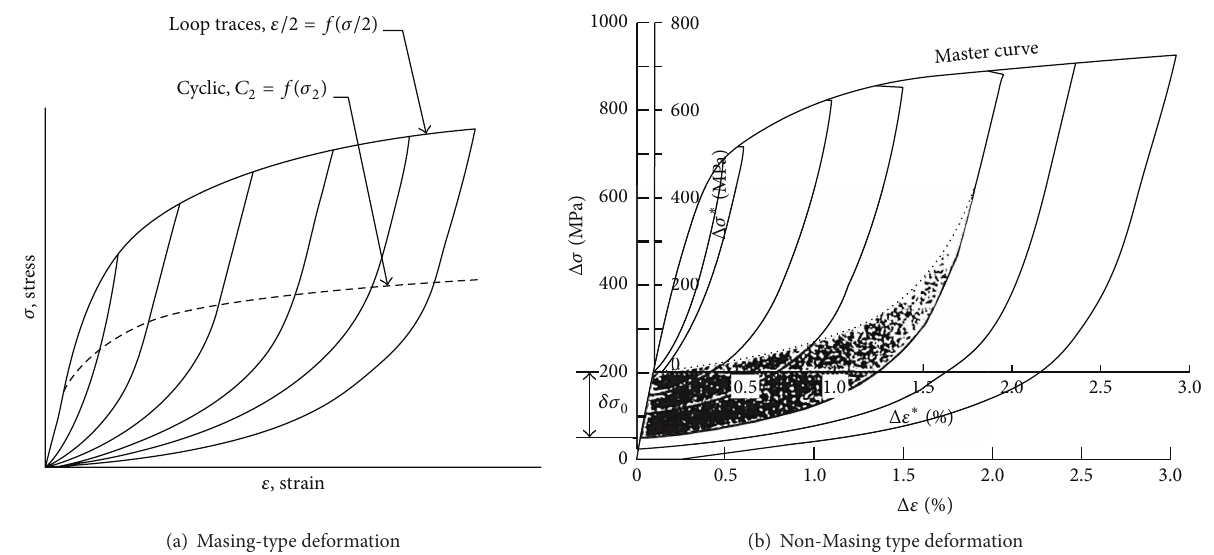
Figure 5: Materials exhibiting hysteresis loops with (a) Masing-type deformation and (b) non-Masing type deformation (Adapted from [39]).